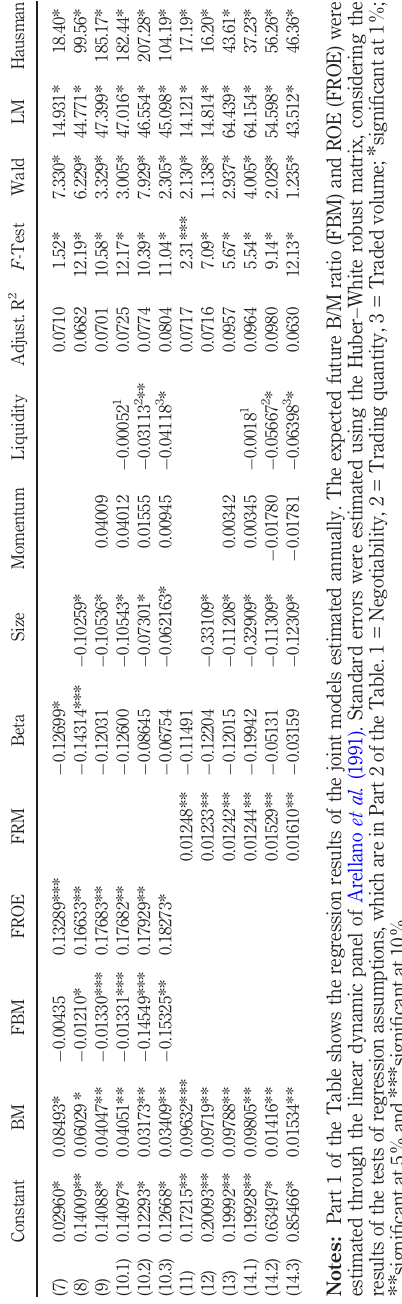
Table IX. Regression results of the joint